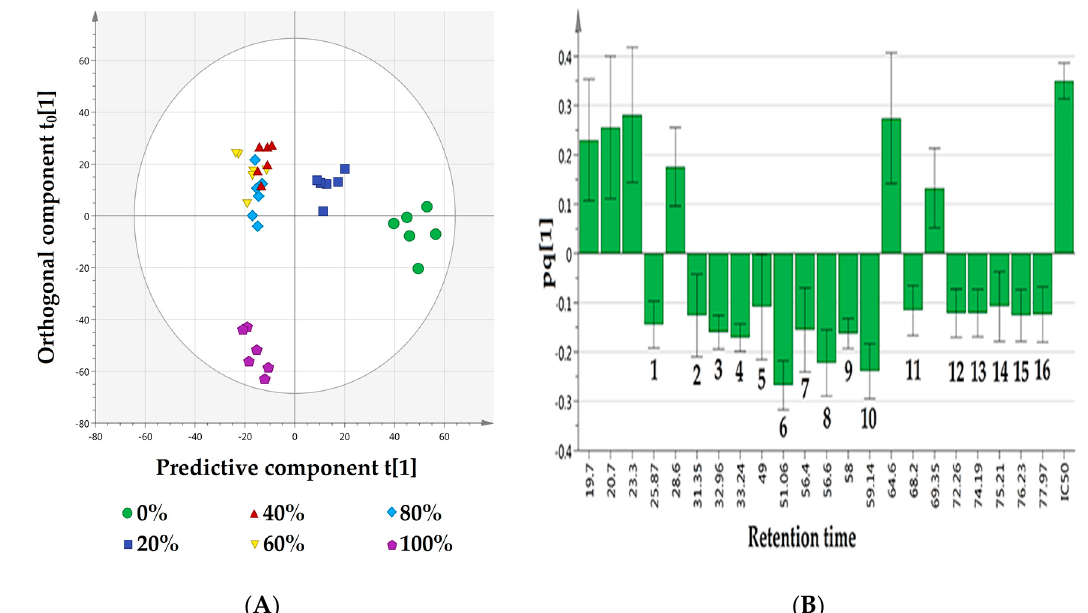
Figure 4. ( A ) Scores scatter plot of the established orthogonal partial least squares (OPLS) model for T. scandens leaves extracts, showing the highly active extracts on the negative side of the predictive component t[1], while the less active extracts on its positive side. ( B ) Loading column plot of the developed OPLS model.